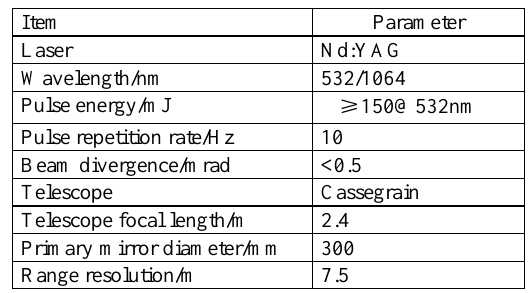
Table 1. Main specifications of